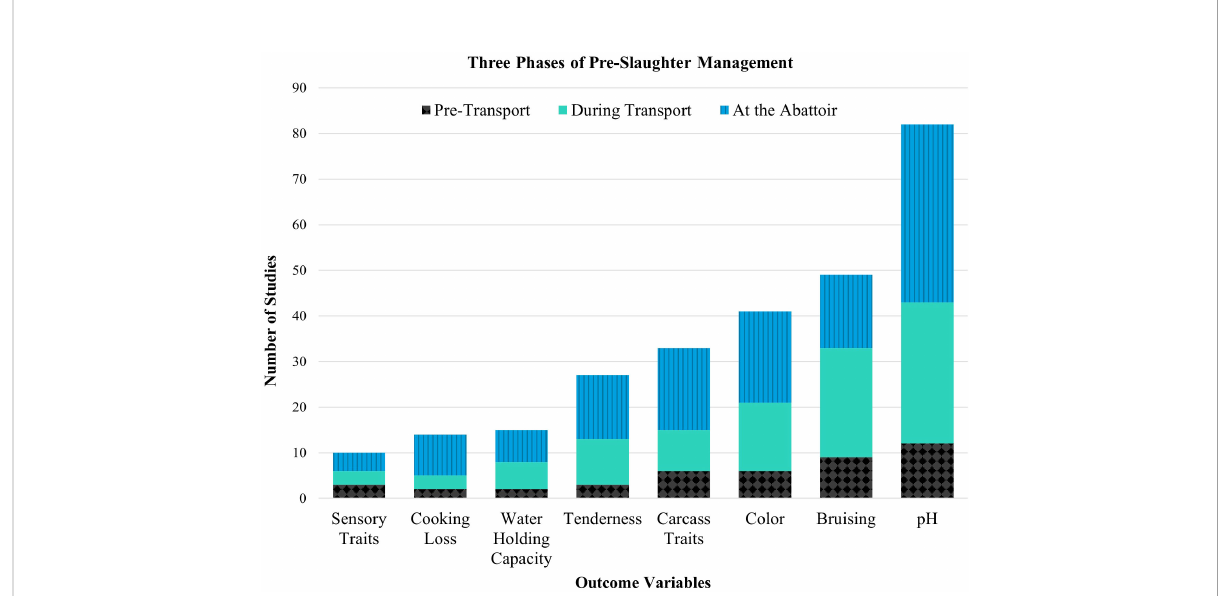
FIGURE 5 Number of studies that reported meat quality outcomes by using factors in each phase of pre-slaughter management ( n =85). Some studies may have researched more than one pre-slaughter factor and measured more than one